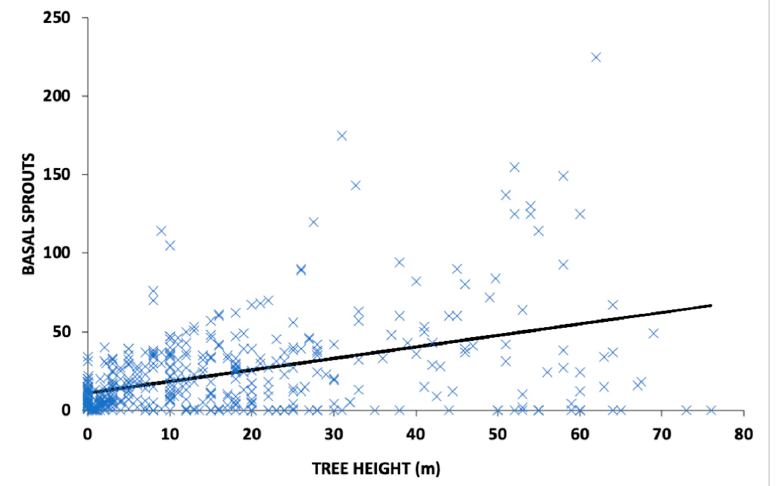
Figure 3. Scatter plot of the number of post ‐ fire basal sprouts combined for Sequoia sempervirens (D. Don) Endl. ; Notholithocarpus densiflorus (Hook. & Arn.) Manos ; Quercus agrifolia Nee. ; Myrica californica (Cham. & Schltdl.) Wilbur ; and Arbutus menziesii Pursh), in relation to tree height produced in response to a high severity crown fire in Big Basin Redwoods State Park, California .